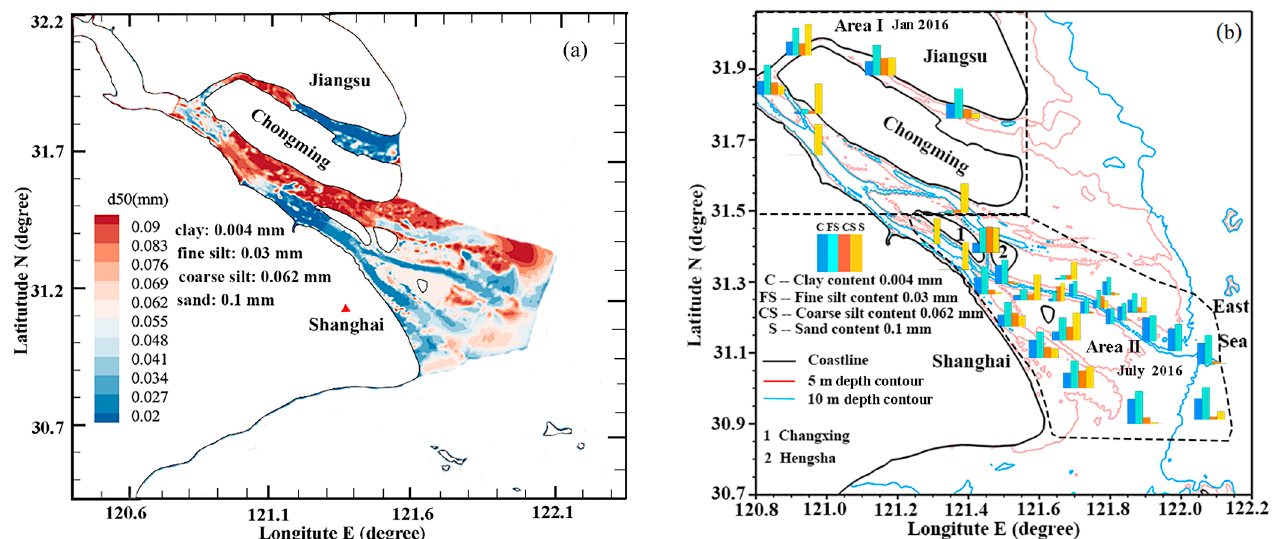
Figure 4. ( a ) Spatial distribution of bed sediment composition (using d 50 as an example) in part of the Yangtze Estuary, which was obtained by interpolation using the available measured data in ( b ). ( b ) Indications for the available measured surficial bed sediment compositions in the Yangtze Estuary (data in Area I were measured in January 2016, whereas data in Area II were measured in July 2016).